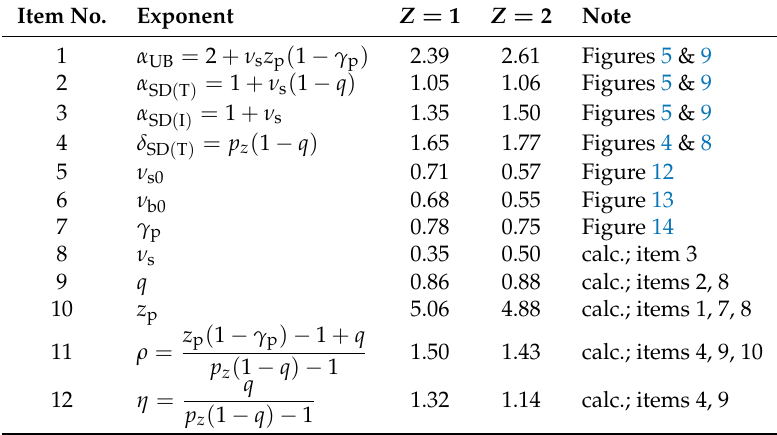
Table 1. List of the exponents in the ( Z :1)-salt solution obtained in this study. Some of the exponents were extracted directly from the simulations. For these, the figure number from which the exponent was obtained is given (in the note column). For the exponents calculated indirectly from the extracted exponents, the word “calc.” is denoted, following the item numbers from which it was calculated. Item No. Exponent Z = 1 Z =